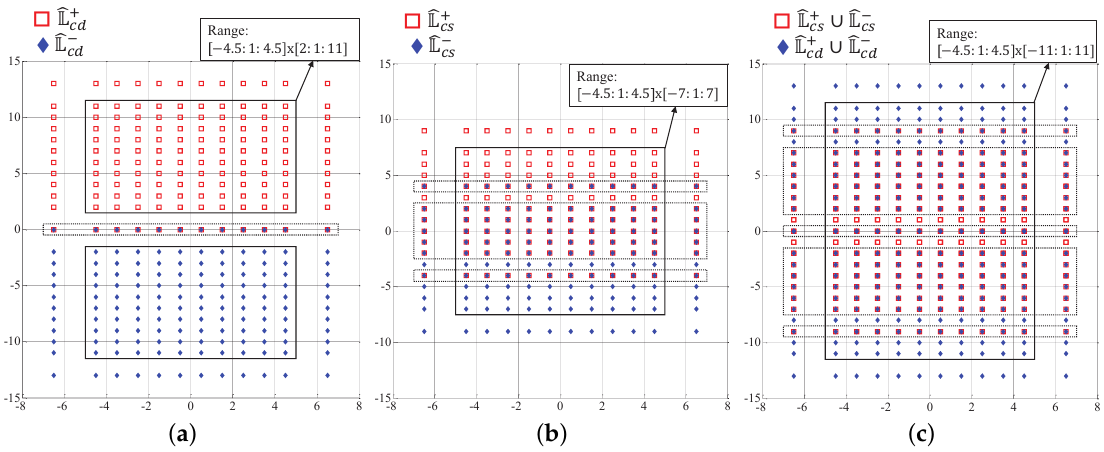
Figure 6. Cross coarrays of CATSS, where M 1 = 4, M 2 = 3, p = 2, and l = 0. ( a ) The cross-difference coarray. ( b ) The cross-sum coarray. ( c ) The cross-diff-sum coarray. Dashline boxes mark the overlapped area of the coarrays in each